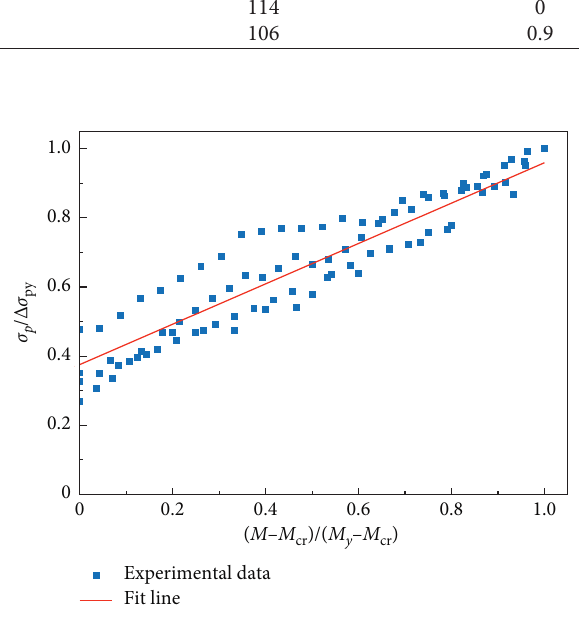
Figure 9: The relationship between Δ σ (M y − M cr